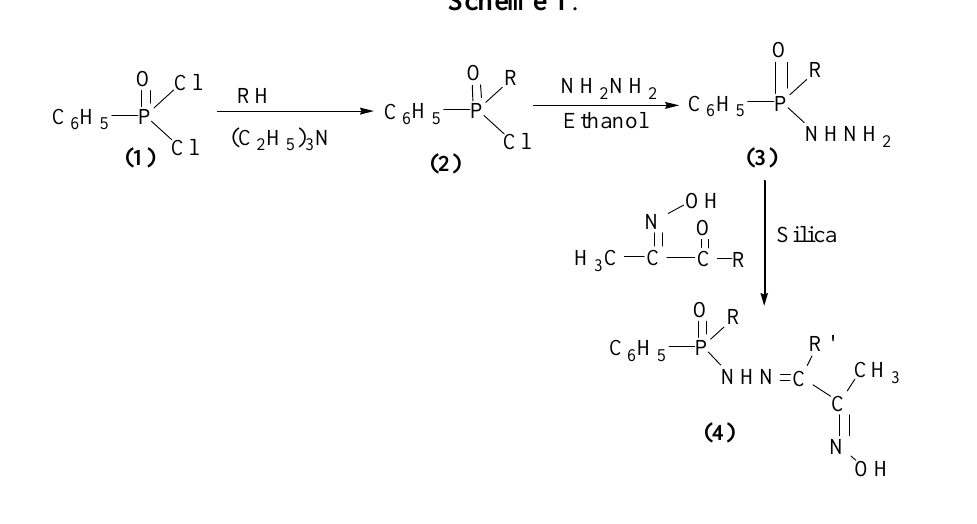
Table-1 Physical data of the newly synthesized compounds 4 a